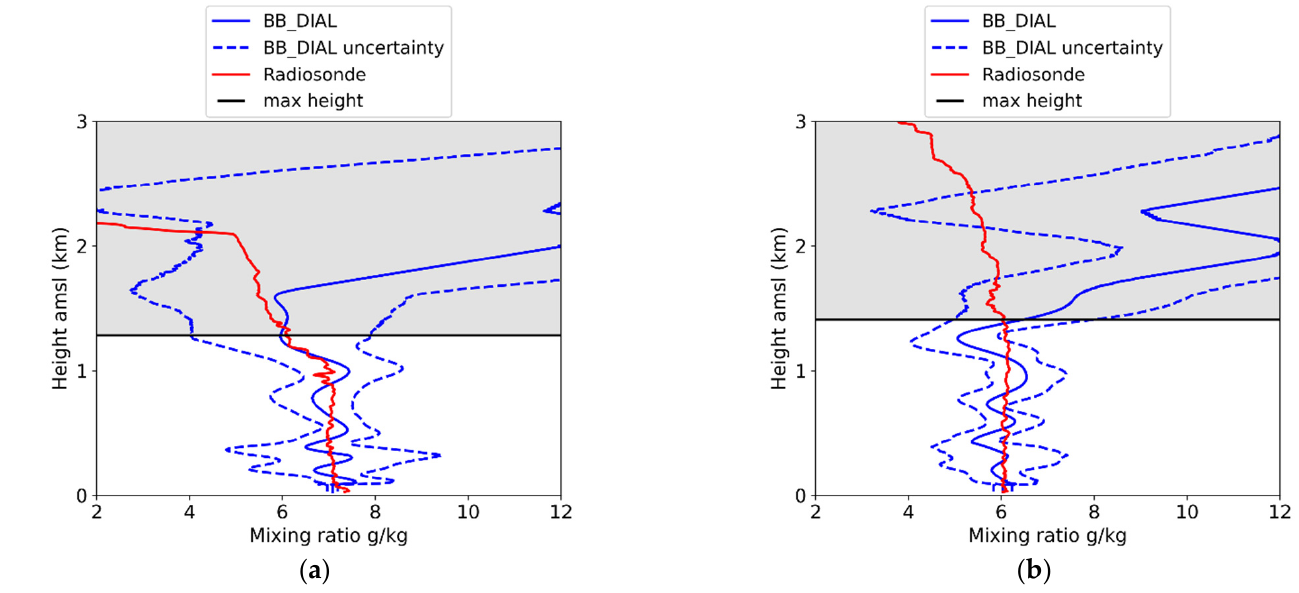
Figure 20. Examples of unrealistic oscillations in the BB-DIAL estimated mixing ratio profile with coinciding radiosonde measurements. The horizontal line indicates the BB-DIAL maximum height. ( a ) 14 July 2020 14:00 UTC, ( b ) 15 June 2020 12:00 UTC4.3. Dry Layer Above